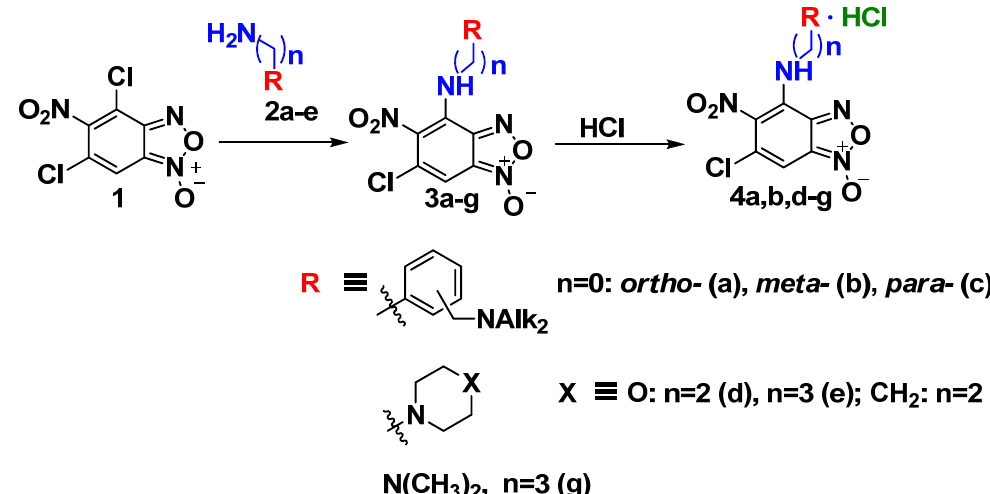
Scheme 1. Obtaining water ‐ soluble salts of benzofuroxans in two stages.